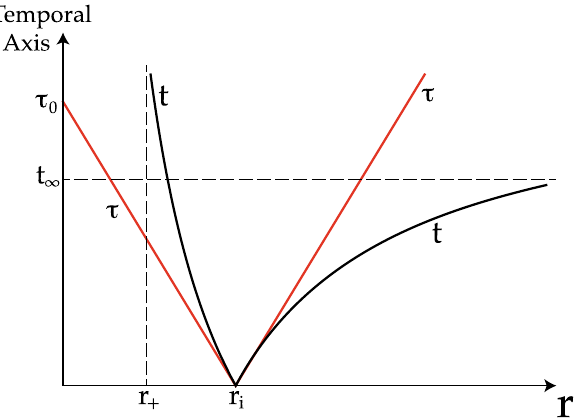
Fig. 3 Plot for the turning point or apoastron, r t as a function of the impact parameter b . The validity of this function is in b c < b < ∞ Using the